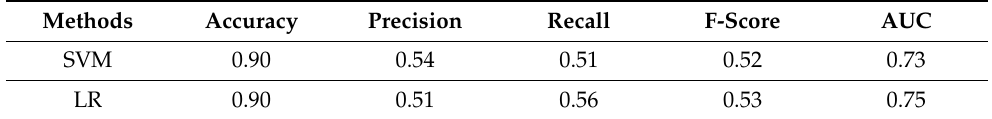
Table 2. The baseline results by SVM and logistic regression.